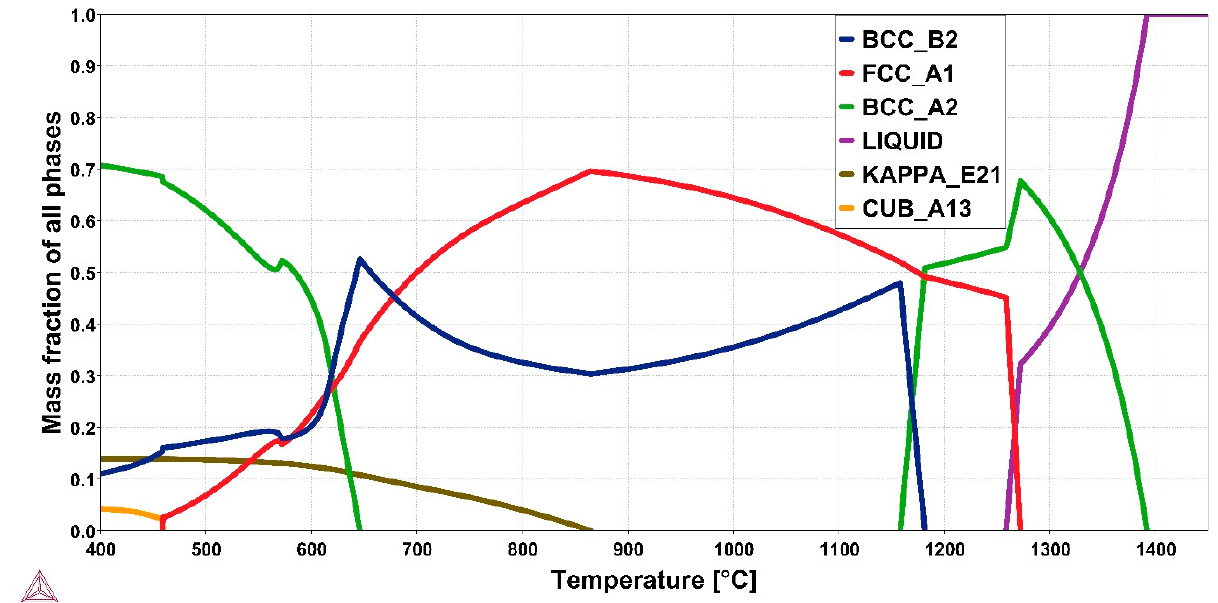
Figure 1. Thermo-Calc calculation of equilibrium amount of phase in Fe-Mn-Al-Ni-C at different temperatures.